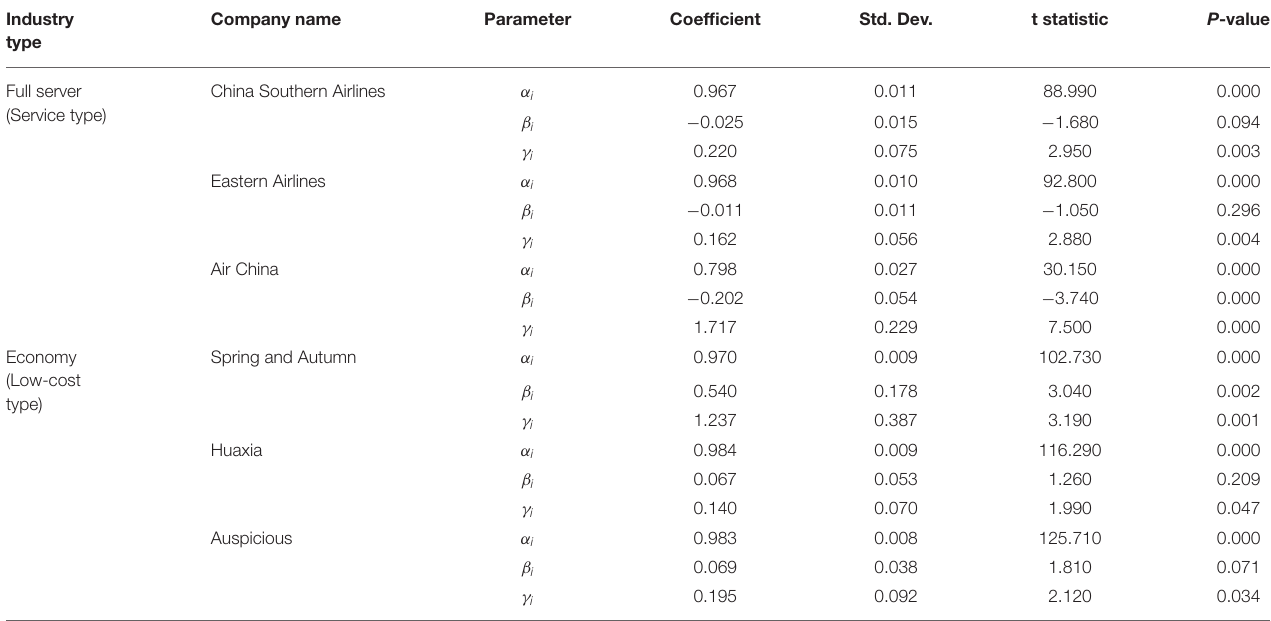
TABLE 4 | The impact of the pandemic on the stocks of Chinese airlines.